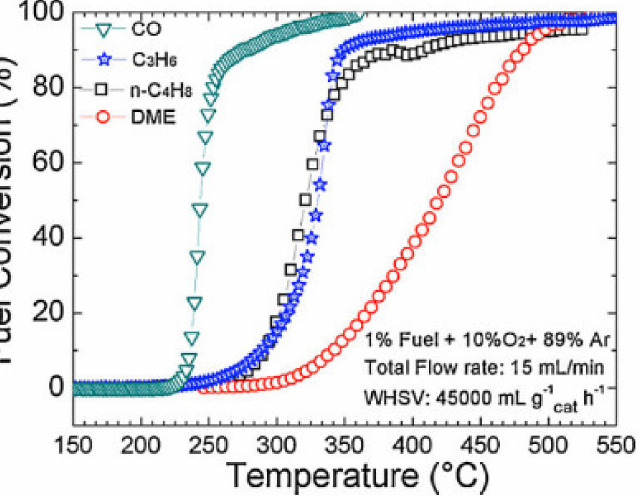
Figure 11. Temperature dependence versus conversion of CO, C 3 H 6 , n -C 4 H 8 , and DME in the oxidation reaction over the PSE-CVD-made CoFe 2 O 4 sample (reproduced from Ref. [209]). The conversion of C 3 H 6 , n -C 4 H 8 , and DME indicated that the Co 2 . 1 Fe 0 . 9 O 4 catalyst